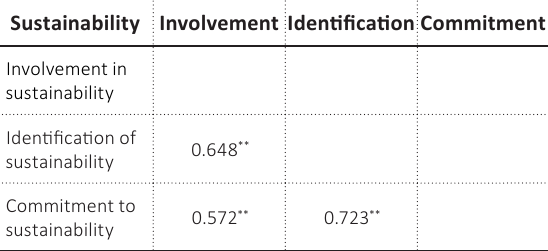
Table 2. Pearson correlation of